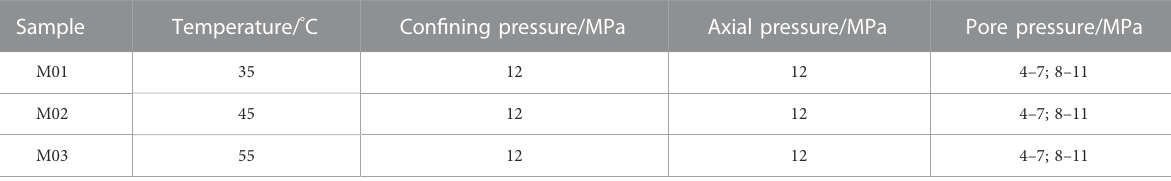
FIGURE 3 Adsorption experimental device.